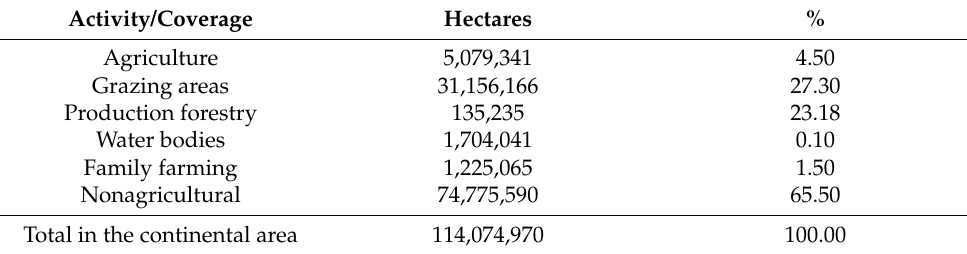
Table 8. Areas analyzed for the generation of areas in agricultural activity. Source: